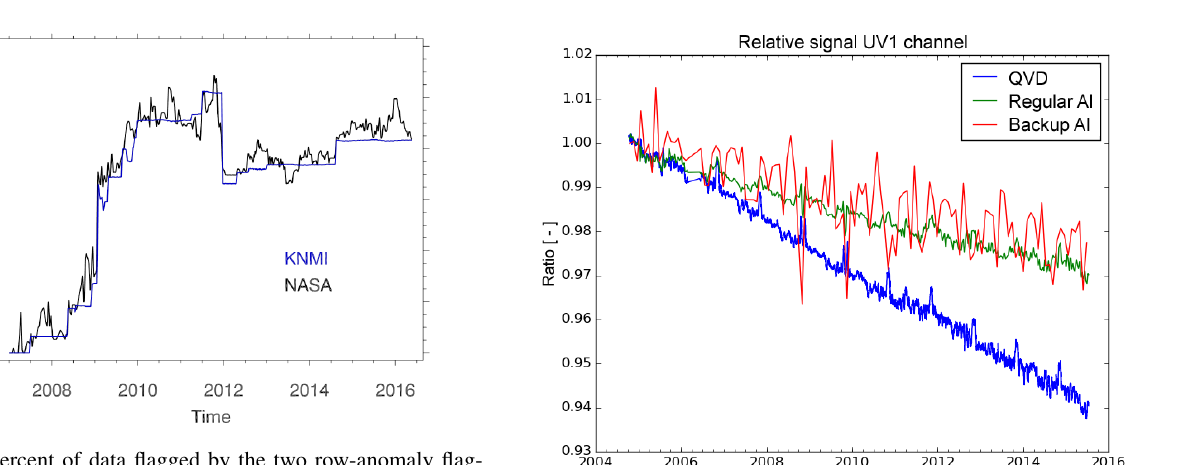
Figure 25. Percent of data flagged by the two row-anomaly flag- ging algorithms in use for the UV2 channel. The KNMI algorithm is used to flag the L1B radiance products, while the NASA algo- rithm is used in several NASA retrieval algorithms to flag the L2 data. Though the physical basis of the two algorithms is rather dif- ferent, they produce consistent flagging results over the full course of the OMI mission. The presence of high-frequency variations in the NASA flagging algorithm is due to the fact that it flags data dy- namically, while the KNMI row-anomaly flags are changed as need determines.